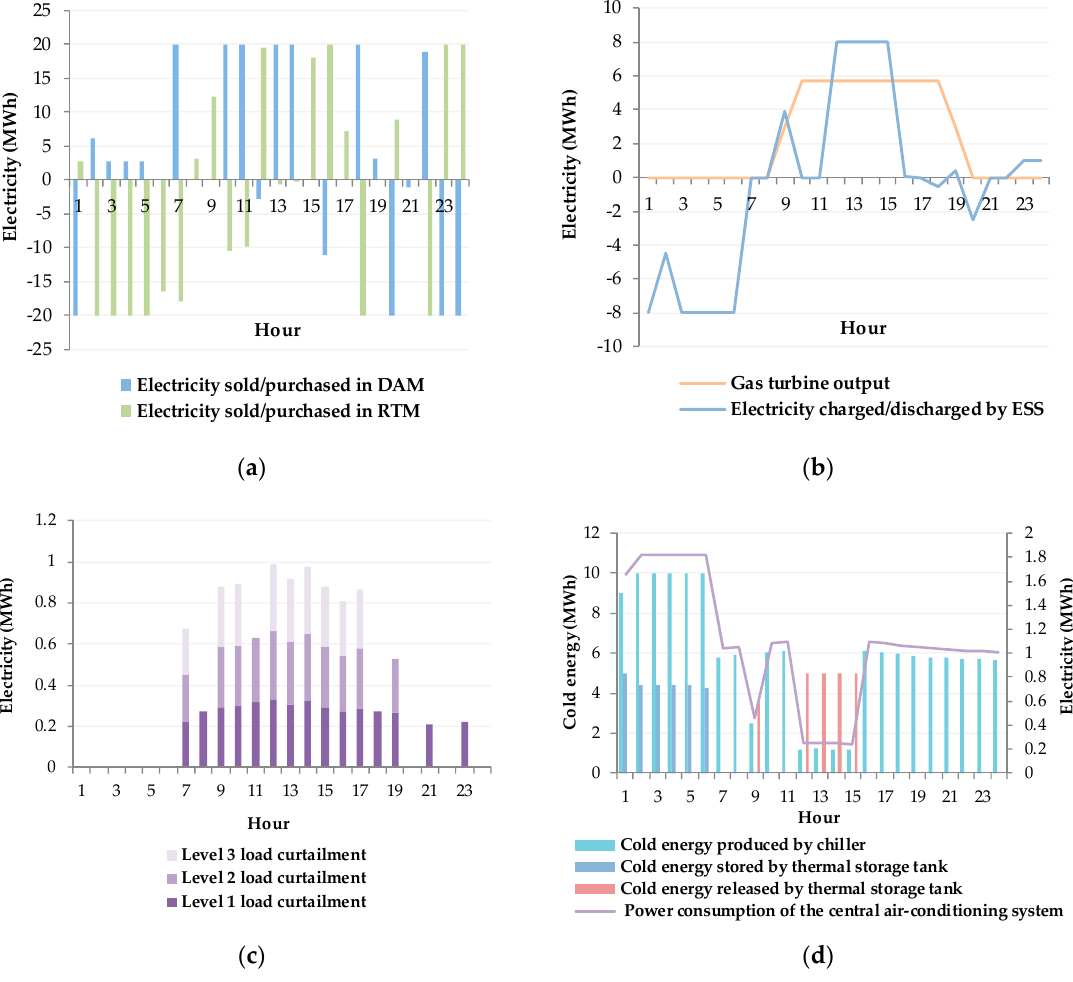
Figure 5. Optimized VPP dispatch results: ( a ) electricity sold/purchased in the DAM and RTM; ( b ) gas turbine and ESS dispatch; ( c ) interruptible load dispatch; ( d ) CACS dispatch.